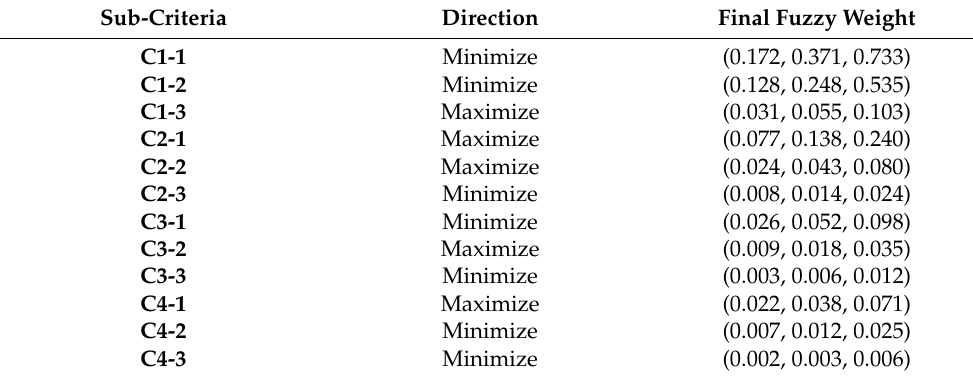
Table 13. Sub-criteria final fuzzy